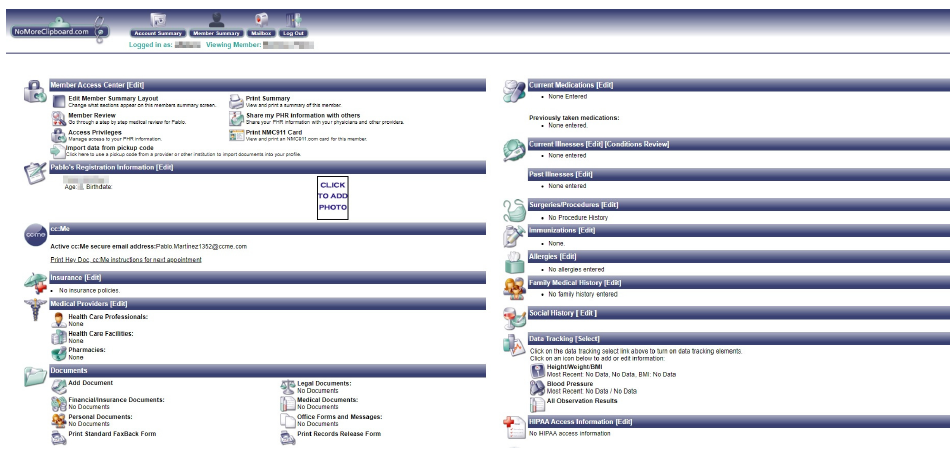
Figure 10. NoMoreClipBoard screen